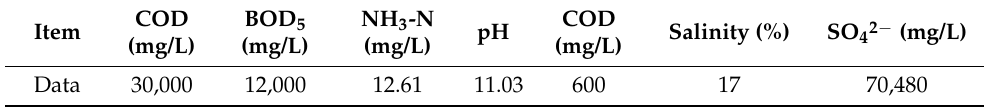
Table 1. Quality of the original